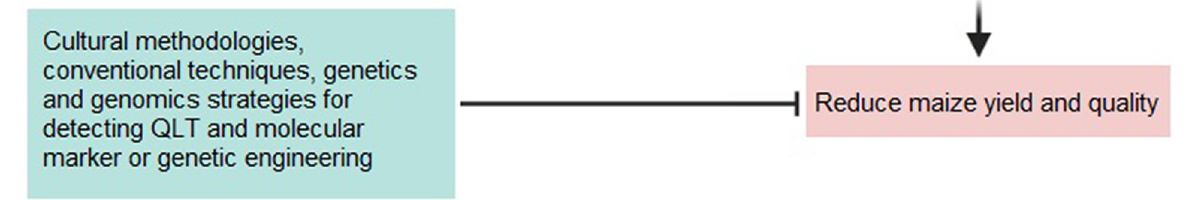
outcomes at the jointing and silking stage (Chen K. et al., 2018). Similarly, soil moisture contents before, during, and after silking result in a severe reduction in yield by 25, 21, and 50%, respectively (Pandey et al., 2000). The optimum temperature at tasseling is between 21 and 30 ◦ C (Kiniry and Bonhomme,